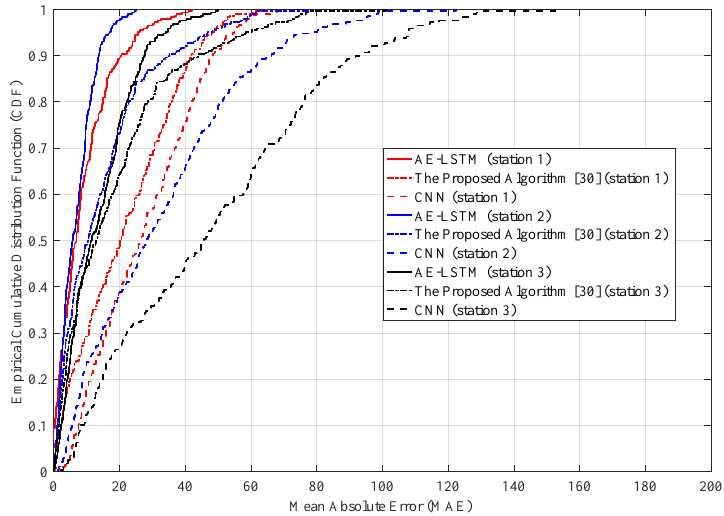
Figure 6. The cumulative distribution of MAE at different